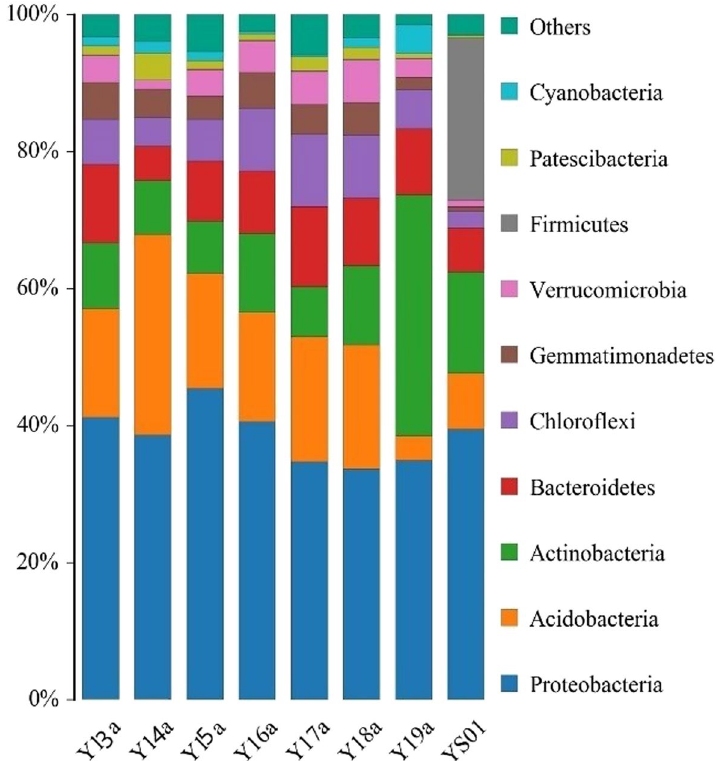
Fig. 3 Distribution map of bacterial communities at the phylum